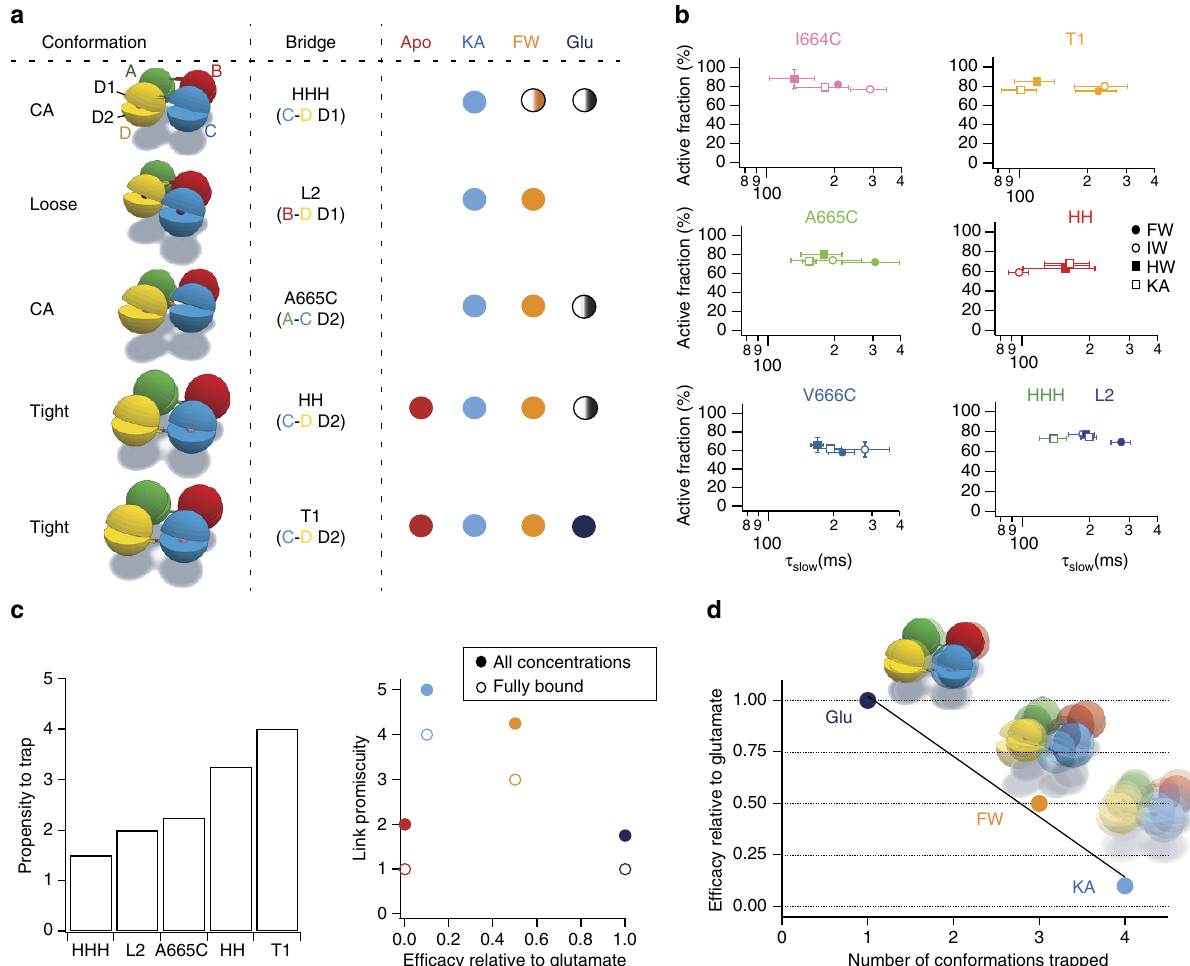
Figure 7 | The promiscuity of cross-linking is inversely correlated with agonist efficacy. ( a ) The table presents the cartoons of the closed angle 22 , Loose and Tight conformations 23 , showing the localization of the engineered bridges that either crosslink the upper D1 or the lower D2 lobe of the individual subunits (A in green, B in red, C in blue and D in yellow). The entries in the table indicate observed crosslinks for the different trapping mutations that were tested in the presence of KA, FW and glutamate. Full circles indicate trapping at saturating concentrations, whereas, half-filled circles indicate trapping at intermediate concentrations of the respective agonist. ( b ) Trapping profiles for all the mutants tested (different colours) in different partial agonists. Each plot compares the active fraction versus the time constant of recovery from trapping ( t slow ). All error bars are s.e.m. ( n ¼ 5). ( c ) Each bridge has a different propensity to trap a range of distinct conformations (left panel). The crosslinking promiscuity (right panel), assessed over all agonist concentrations (filled symbols) or only for fully-bound LBD tetramers (open symbols) is plotted in relation to efficacy. A crosslink in saturating ligand was scored 1 unit, and in partially occupied LBD layers, a crosslink was scored as 0.25 units, because of the greater conformational variation in the latter case. ( d ) Cartoon illustrating the proposed mechanistic relation between conformational ensembles, efficacy and the number of different states trapped for the three classes of represent the breaking of any bridges that formed. The amplitude of the slow component was the trapped fraction, and we subtracted this fraction from 1 to get the active fraction. A log-normal function was fitted to the active fraction of the L2 mutant activated by FW. Disulfide crosslinking of cysteine mutants was performed in a similar way, with patches being modified by CuPhen (10 m M) instead of Zn 2 þ , and being otherwise held in DTT (1mM) rather than EDTA. Following modification in the presence of willardiines, the patches were held in a CuPhen- containing solution for agonist to unbinding for the same period as with experiments with Zn 2 þ . We measured concentration–response curves for wild-type and mutant receptors in the presence of 100 m M CTZ to block desensitization. We obtained the EC 50 and maximum extent of activation relative to glutamate from fits to the Hill equation,